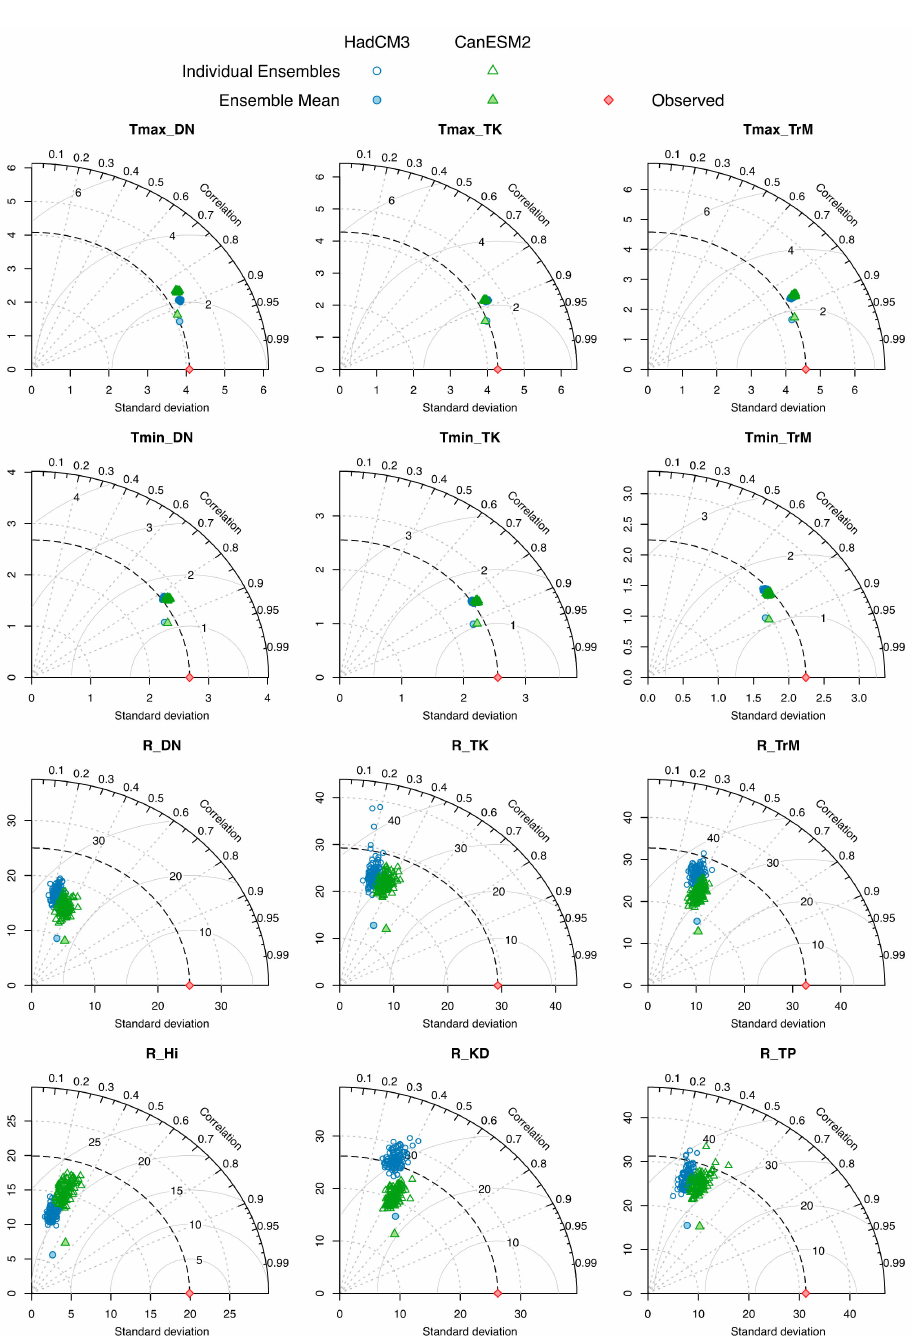
Figure 3. Taylor diagrams for each climatic variable at individual stations during validation. Tmax, Tmin, and R stand for maximum and minimum temperature and